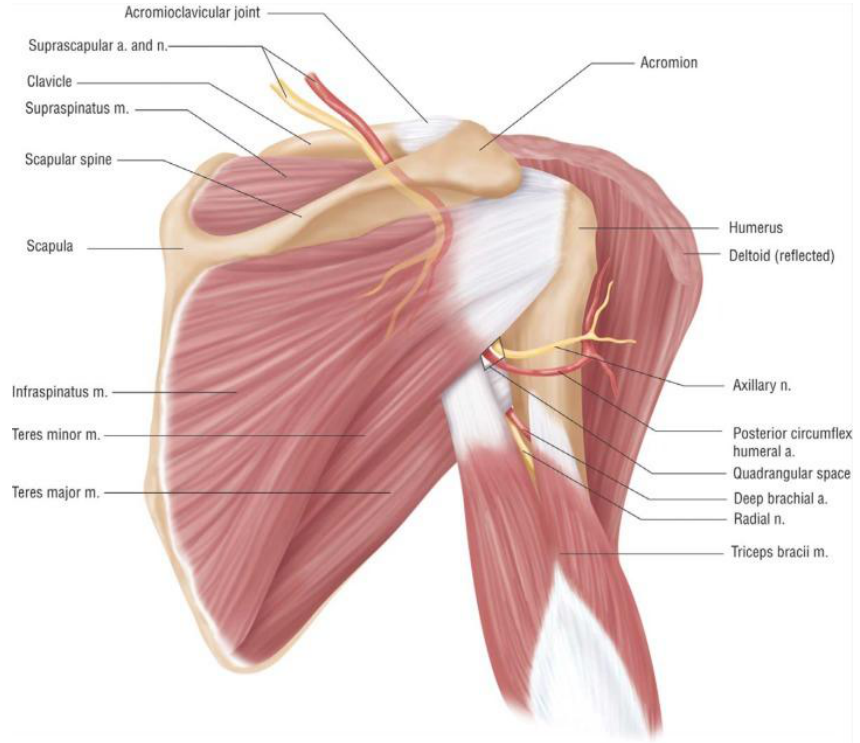
Figure 1. Anatomy of the quadrilateral space. This posterior view of the right shoulder shows the quadrilateral space which is bounded superiorly by the teres minor muscle, inferiorly by the teres major muscle, medially by the long head of the triceps, and laterally by the humeral shaft (reprinted with permission from [1 4